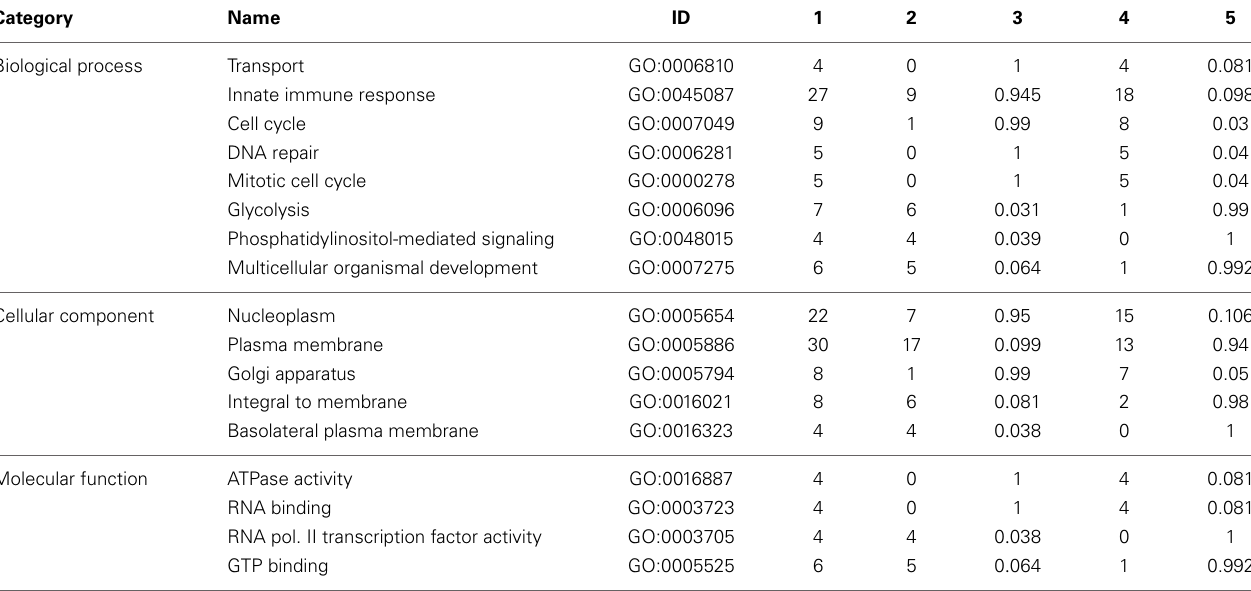
Table 3 | Gene ontology analysis of susceptible dark-eyed pupae (G4 + /G4 − ).